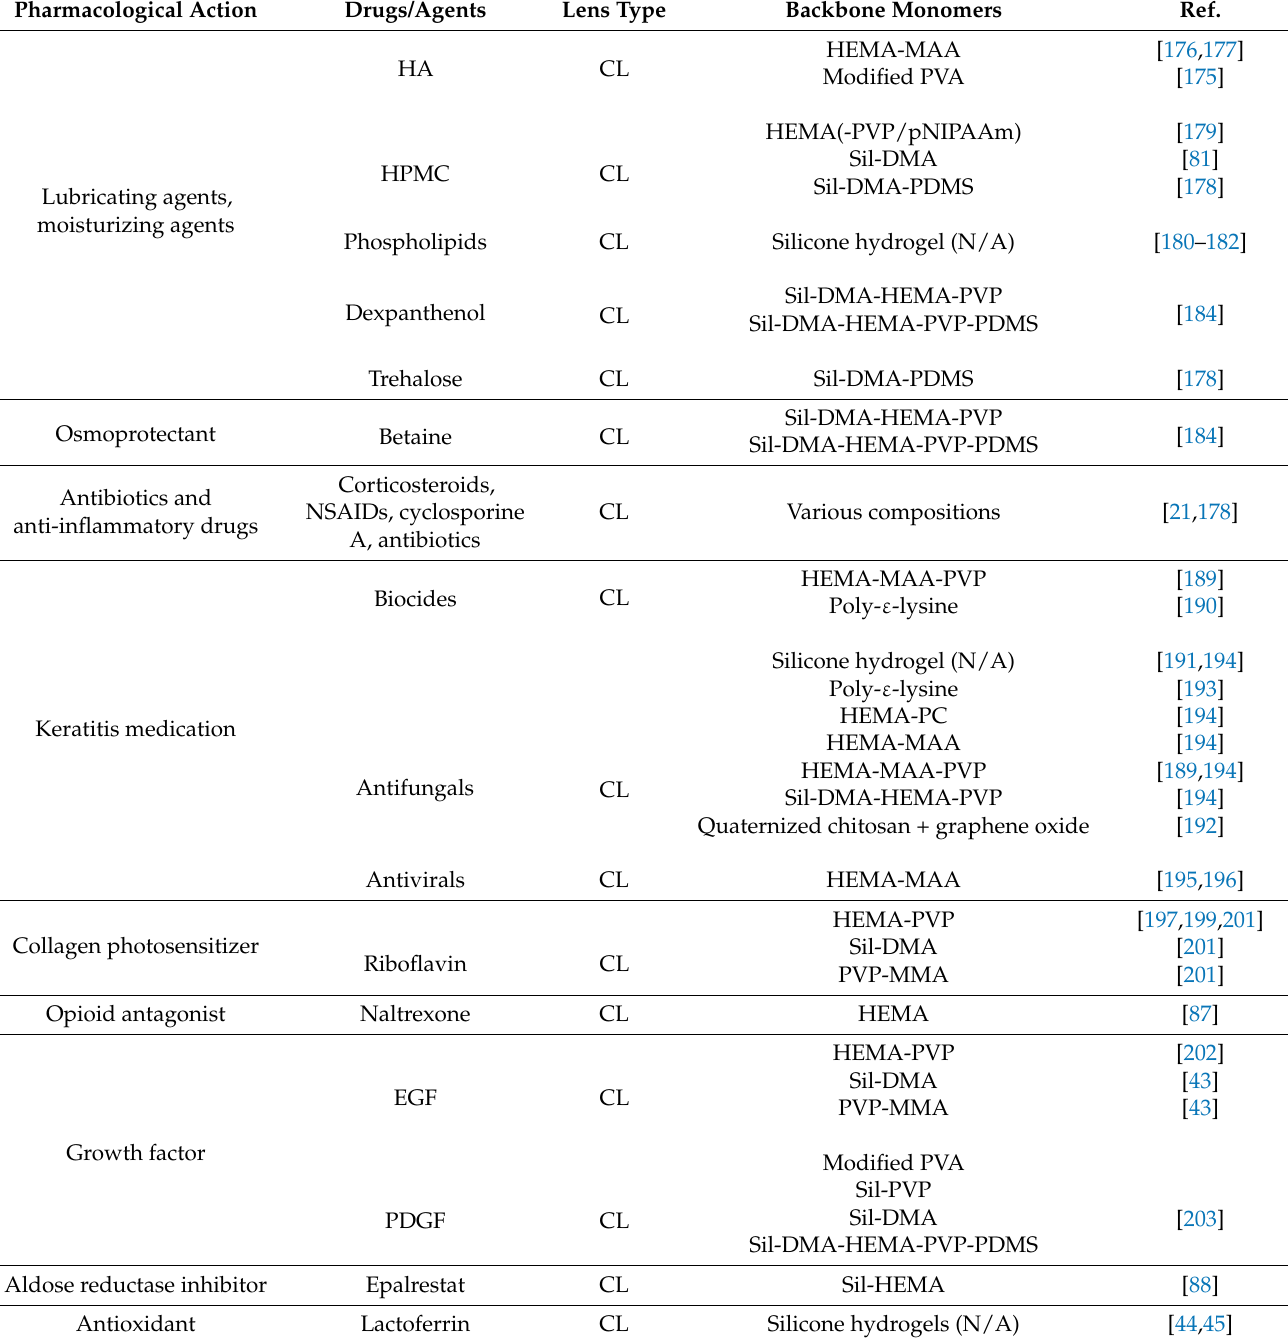
Table 3. Therapeutic ophthalmic lenses developed between 2010 and 2020 suitable for the prevention and treatment of corneal